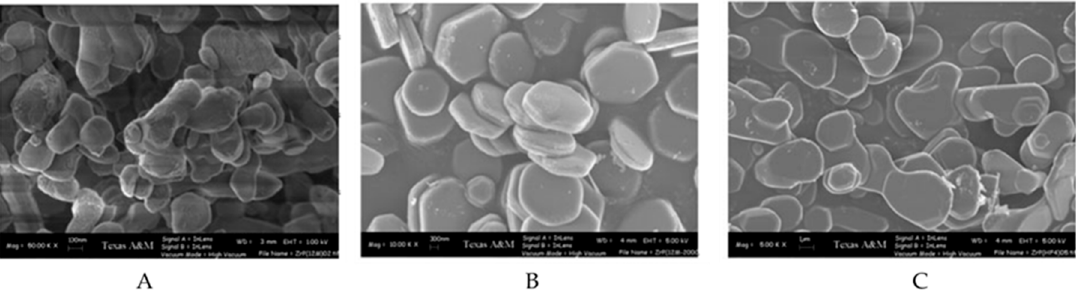
Figure 2. SEM images of α -ZrP prepared by ( A ) reflux method (12 M H 3 PO 4 ) ( B ) hydrothermal method (9 M H 3 PO 4 ) ( C ) HF method (F / Zr = 4). [34]—Adapted by permission of The Royal Society of Chemistry on behalf of the Centre National de la Recherche Scientifique, 2007.